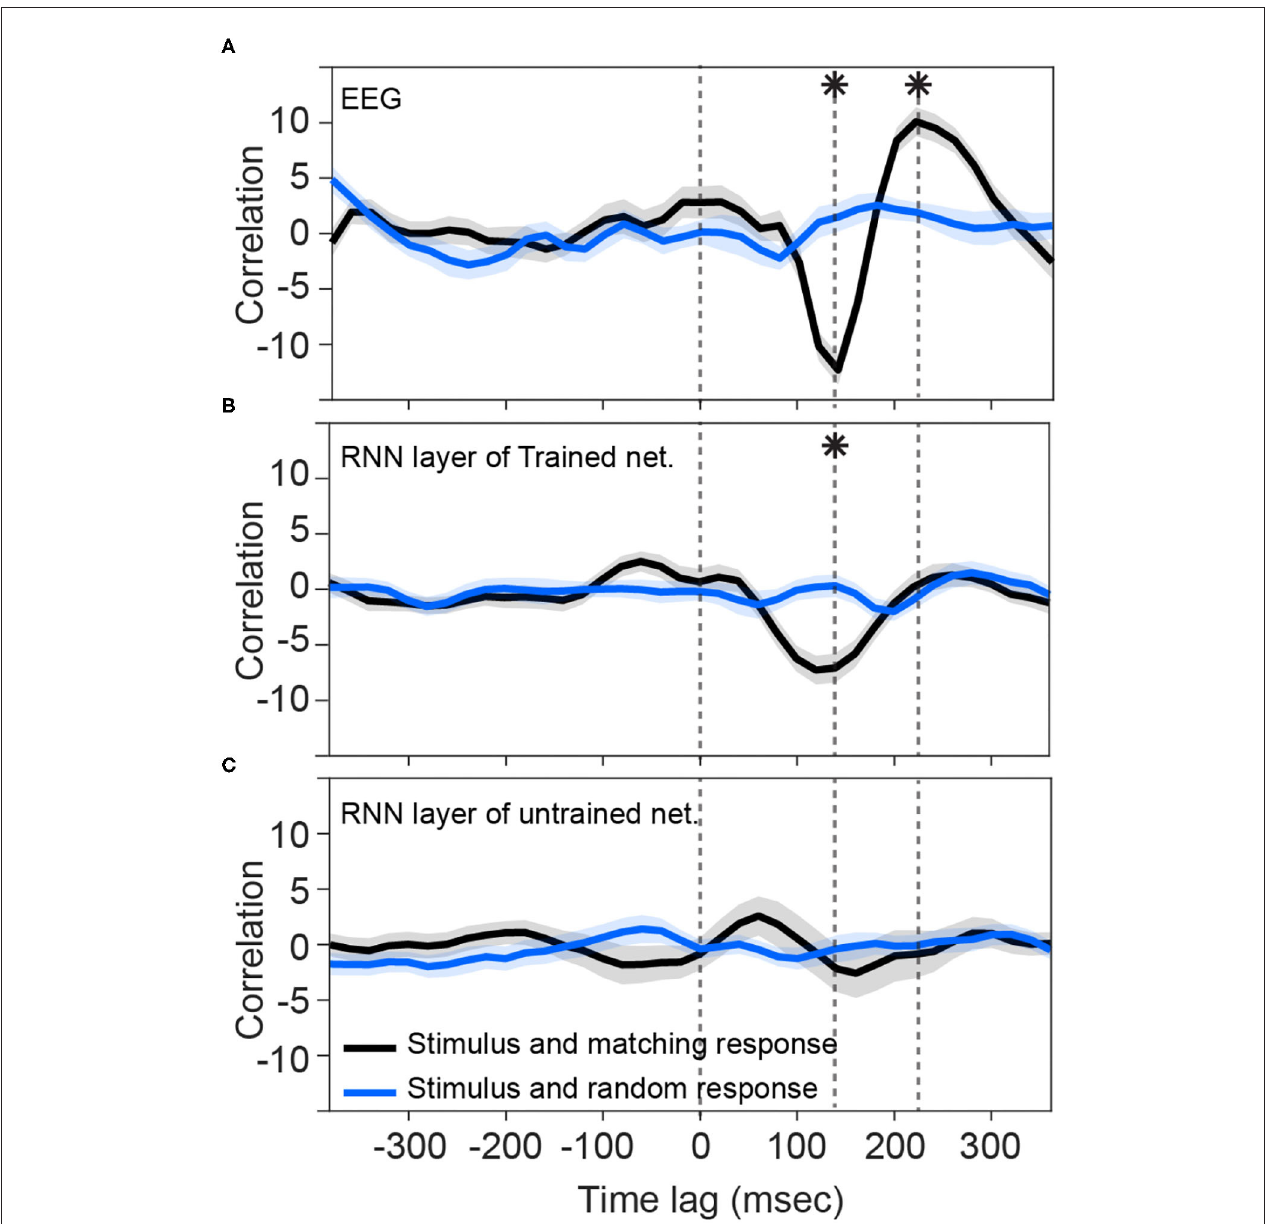
FIGURE 2 | Tracking speech envelope modulations by EEG signals and recurrent output of the network. Correlation function between half-wave positively rectified derivation of the speech envelope and (A) average EEG signal across selected channels, (B) RNN output of the trained network averaged across the nodes in the highest 80 percentile, and (C) RNN output of each 100 shuffle untrained network averaged across the nodes in the highest 80 percentile are calculated. For (C) , correlation functions were then averaged across the shuffles. Solid lines indicate grand mean across the stimuli and their surrounding shadow indicates the Standard Error of Mean (SEM). Solid black curves indicate the correlation between matching pairs of stimuli and response signals, whereas the solid blue curves indicate non-matching pairs of stimulus-response that were chosen randomly. All the signals were time-aligned to the stimulus onset; thus, the positive peak lags represent the delayed responses to the stimulus and negative lags indicate possible brain/network predictions of the future input stimulus. Vertical dashed lines indicate time zero, and the time points of minimum and maximum correlations with EEG. Asterisks indicate where the matching and non-matching cross-correlations are significantly different at those timepoints ( t -test, p < 0.05). Note that the value of the y-axis is the raw cross-correlation, not a correlation